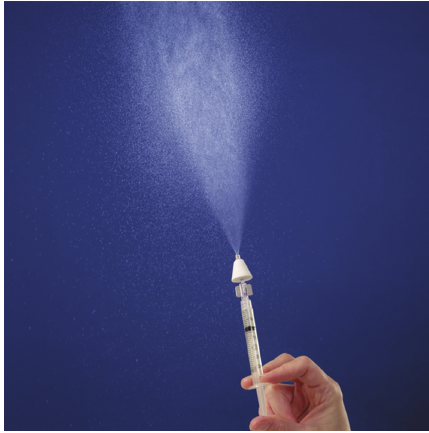
Figure 1: Mucosal atomizer device for delivery of intranasal medication (reproduced with permission from Wolfe Tory Medical, Inc.,